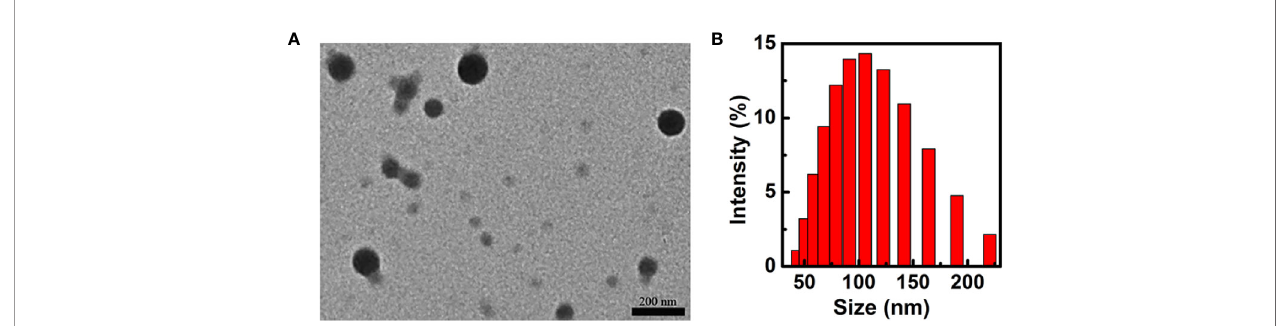
FIGURE 3 | TEM images (A) and particle size and size distribution (B)